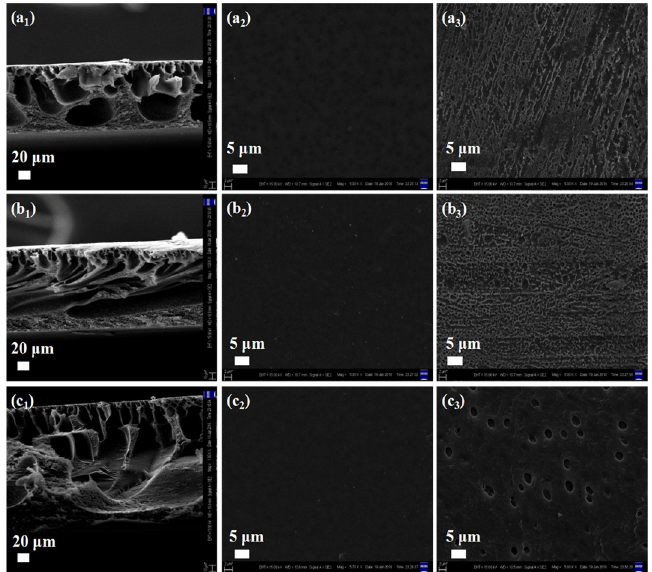
Figure 4. Morphology of cross section ( a 1 –c 1 ), bottom surface ( a 2 –c 2 ) and top surface ( a 3 –c 3 ) of porous PI films: ( a ) 0.2 wt%, ( b ) 0.5 wt%, ( c ) 1.0 wt% .